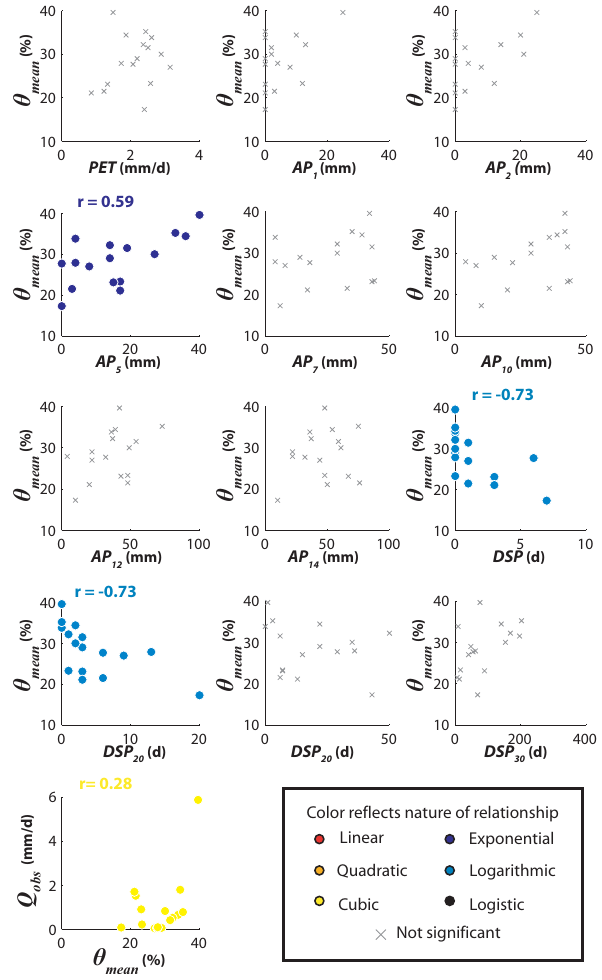
Fig. 7. Relationships between the mean soil moisture content ( θ mean ) and surrogate measures for AMCs and catchment response. “r” refers to the Spearman correlation